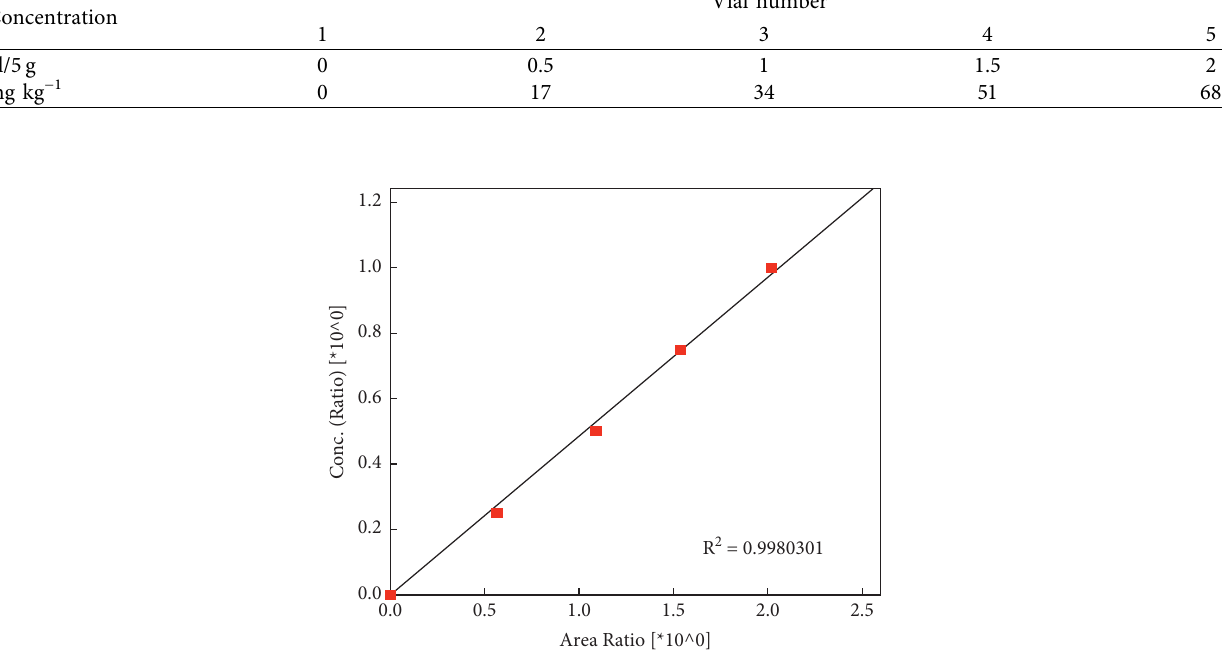
Figure 3: Group-calibration curve of hexane (0–68mg kg − 1 ).